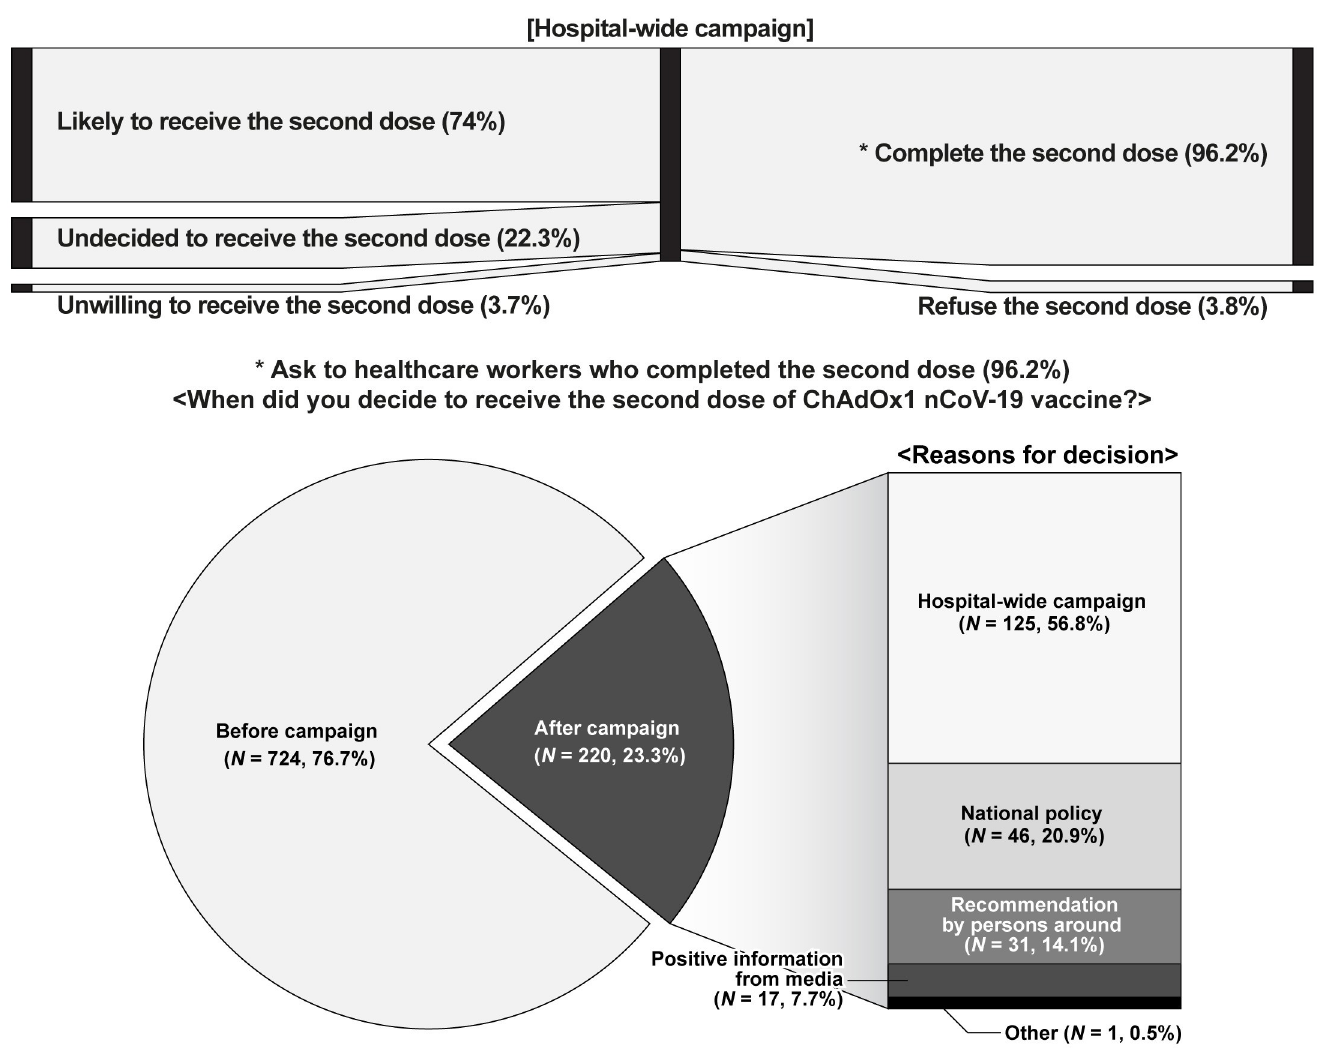
Fig 2. Responses to when the second dose recipients decided to get vaccinated and reasons why the respondents decided to receive the second dose after the hospital-wide